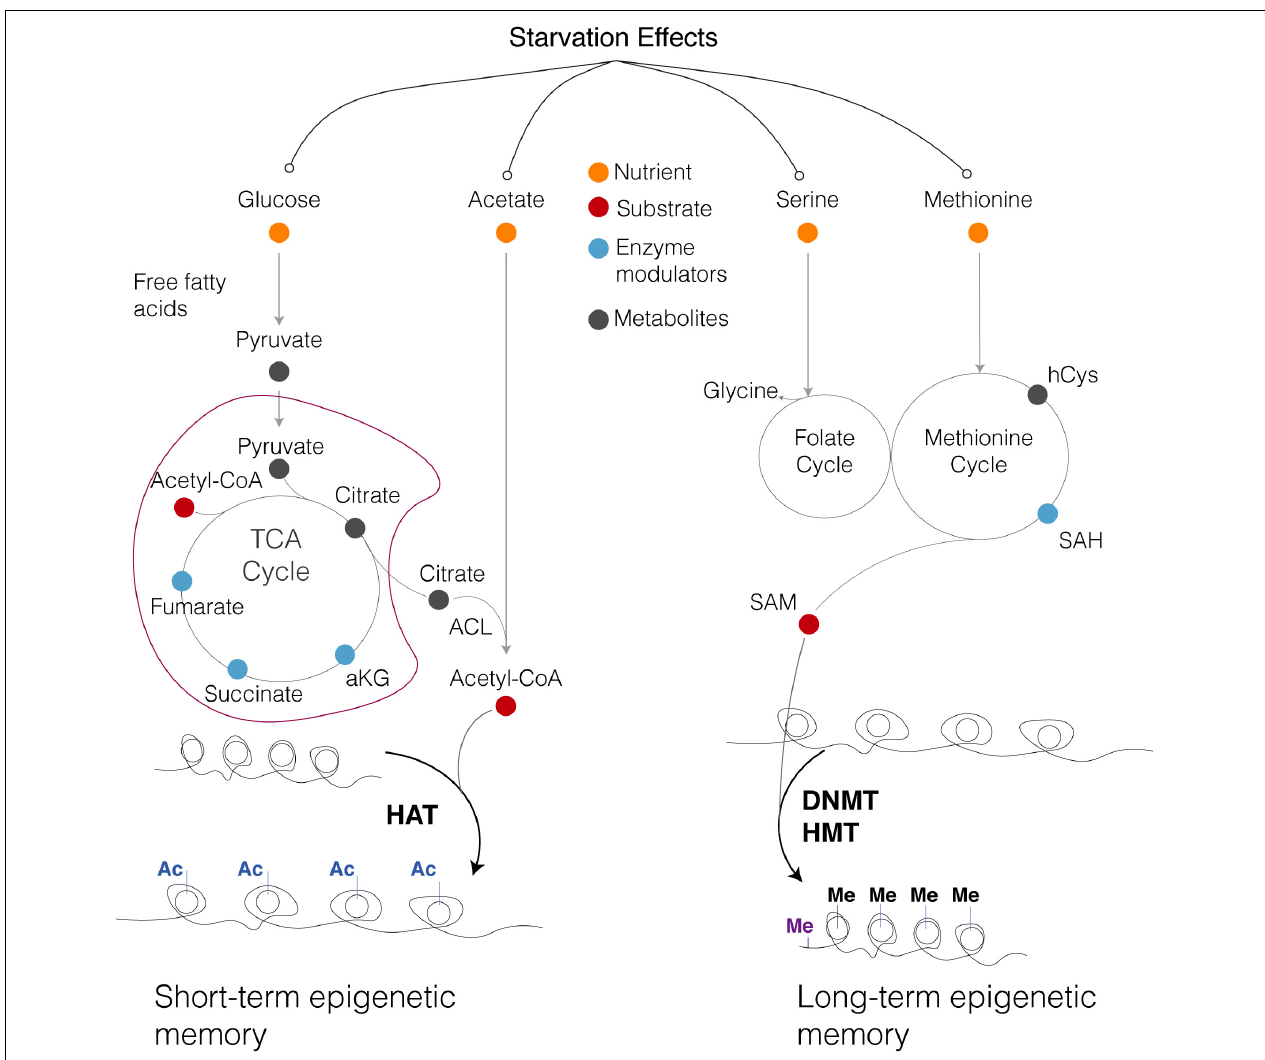
FIGURE 5 | A summary of how starvation-triggered nutrient deprivations converge on epigenetic pathways for short-term and long-term epigenetic memory. Nutrient deprivations that affect glucose, acetate, serine and methionine levels are predicted to impact the efficiency of cellular chromatin modifying reactions. Acteyl-CoA reductions are expected to most strongly affect epigenetic dynamics for short-term memory, while changes to methionine and SAM will affect epigenetic mechanisms mediating longer-term epigenetic effects. Adapted from Reid et al.